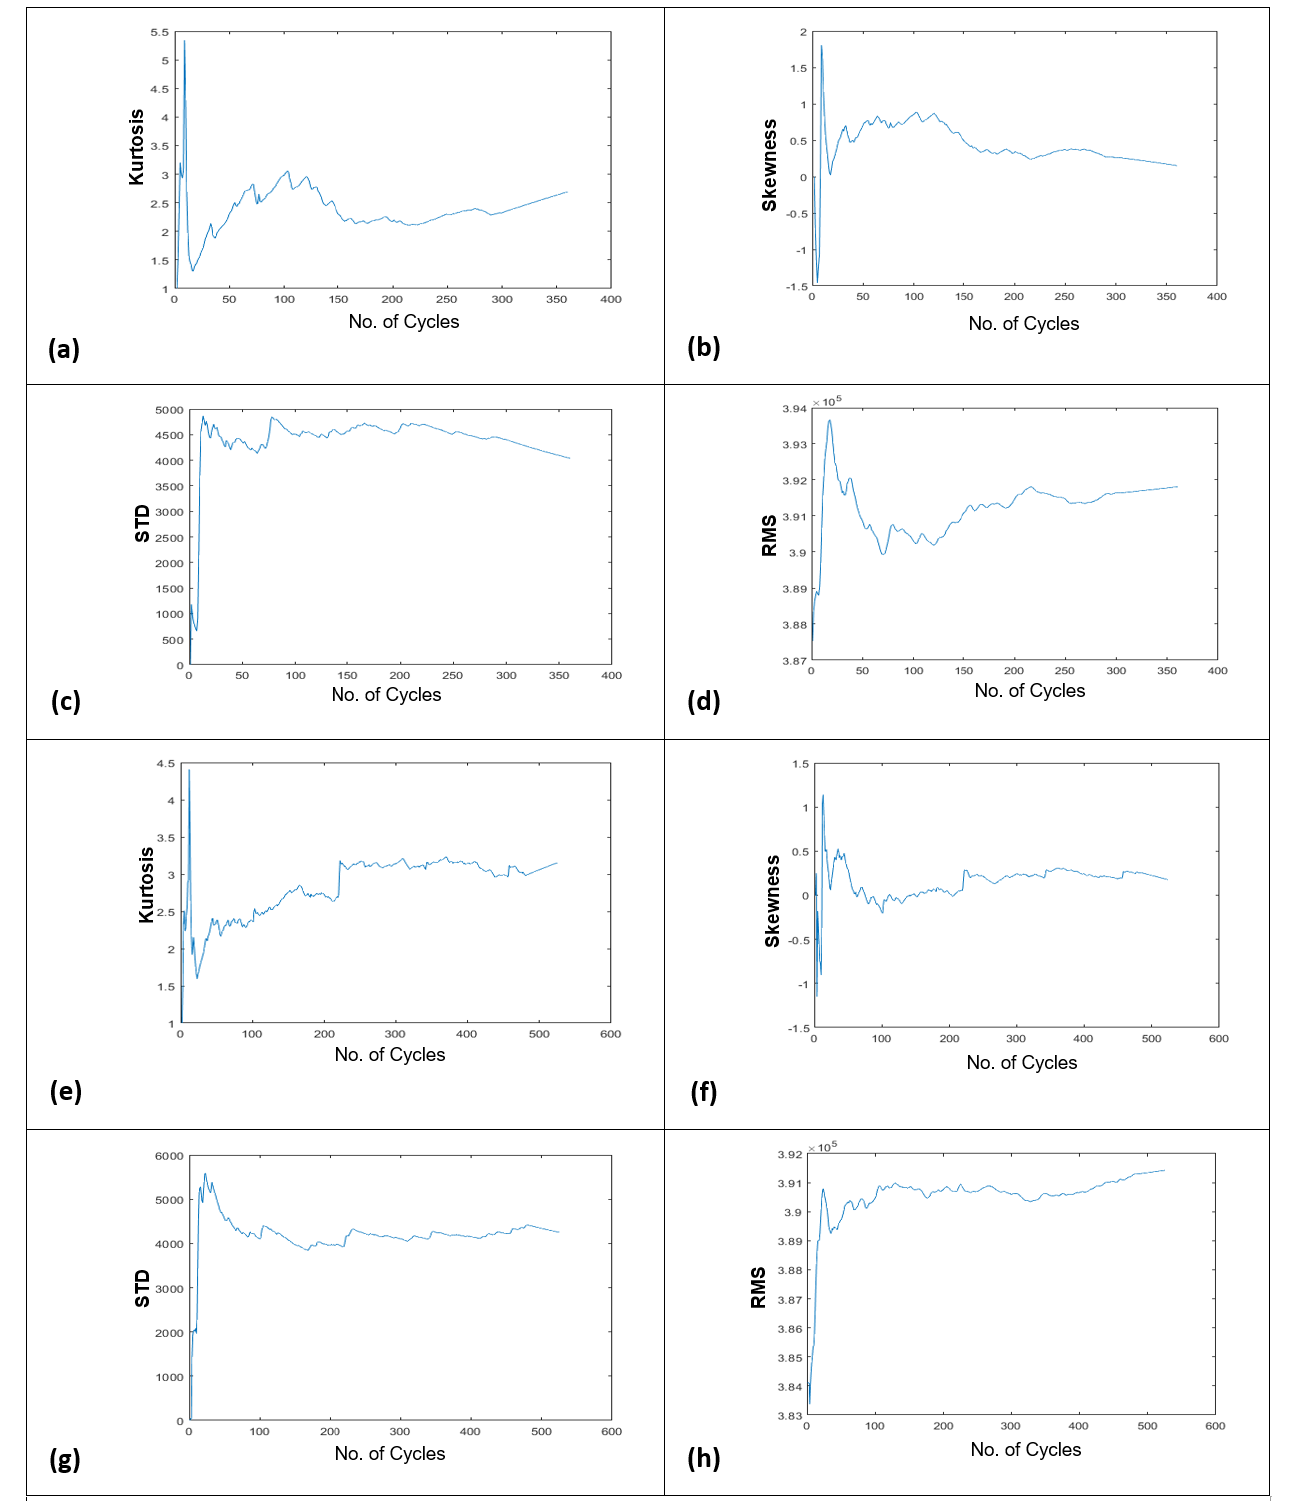
Figure 12. Degradation trends generated by using kurtosis, skewness, St. deviation, and RMS using sub-dataset FD002 for engine 140 ( a - d ), and sub-dataset FD004 for engine 25 ( e - h ).